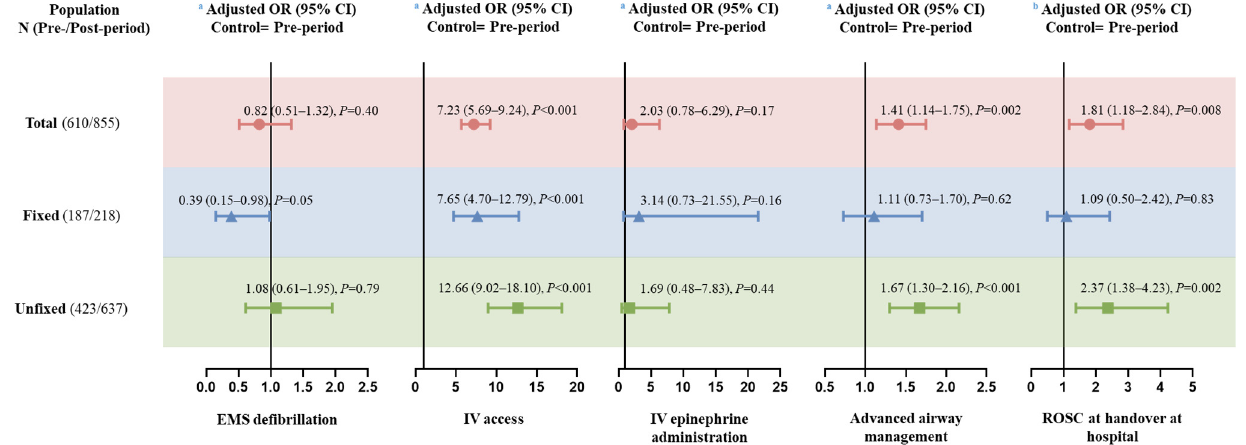
Figure 3. Adjusted logistic regression analysis of the effect of the improvement intervention on outcomes in EMS-treated OHCA patients by the type of ambulance crew. (ORs were calculated for post-period vs. pre-period; a Adjusted for gender, age, location, onset on weekend, call time of the day, CVD history, etiology, onset-to-call time, call-to-arrive time; b Adjusted for gender, age, location, onset on weekend, call time of the day, CVD history, etiology, onset-to-call time, call-to-arrive time, on-scene time, scene-to-hospital time.). EMS, emergency medical services; OHCA, out-of-hospital cardiac arrest; CVD, cardiovascular disease; IV, intravenous; ROSC, return of spontaneous circulation; OR, odds ratio; CI, confidence interval.